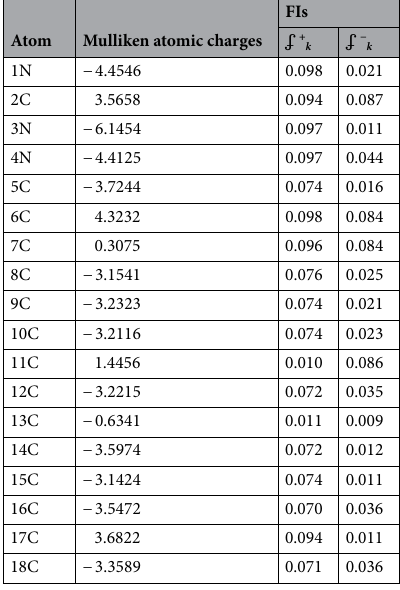
Table 5. Calculated Mulliken atomic charges and FIs of DTG